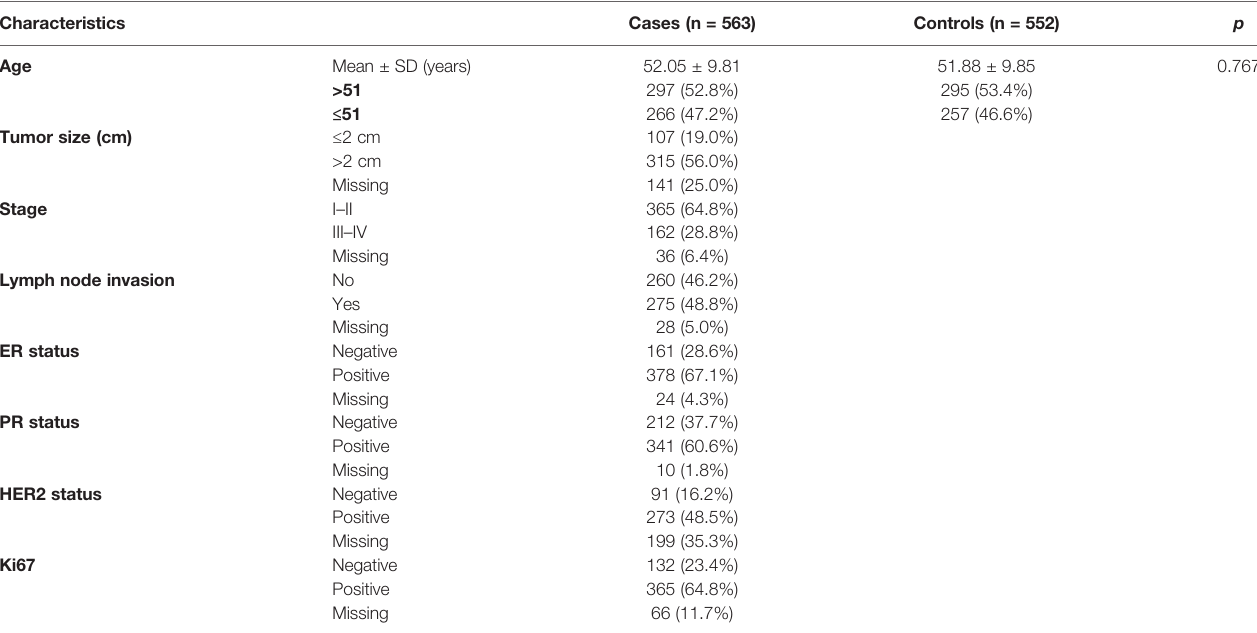
TABLE 1 | Characteristics of patients with breast cancer and